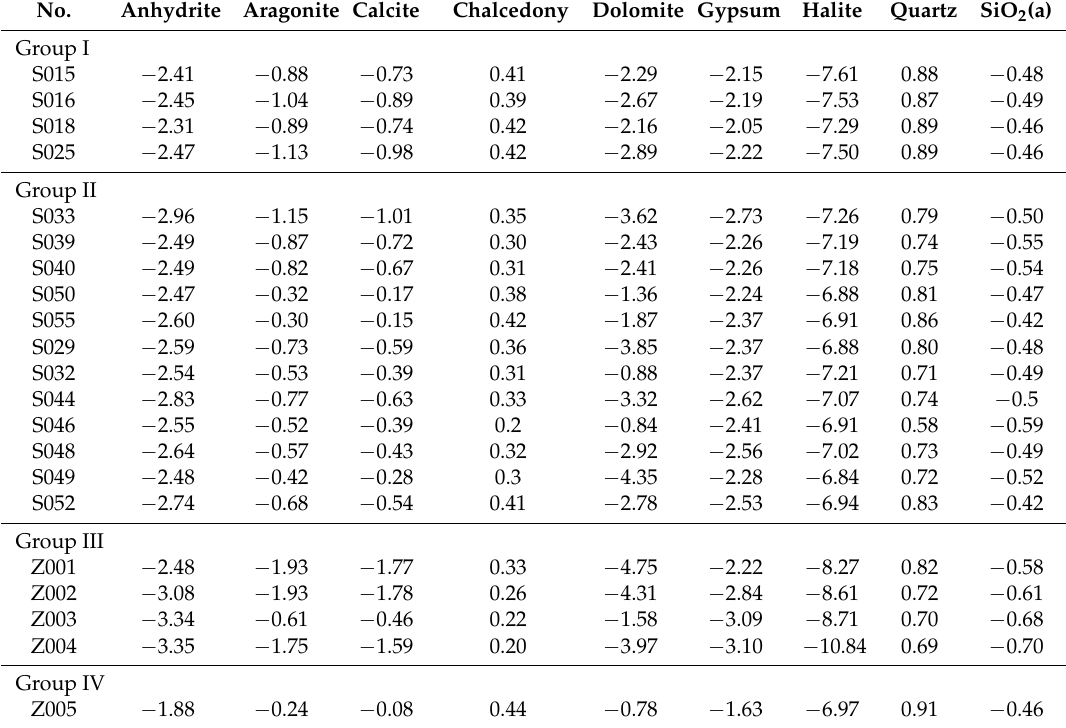
Table 4. Saturation index of the water